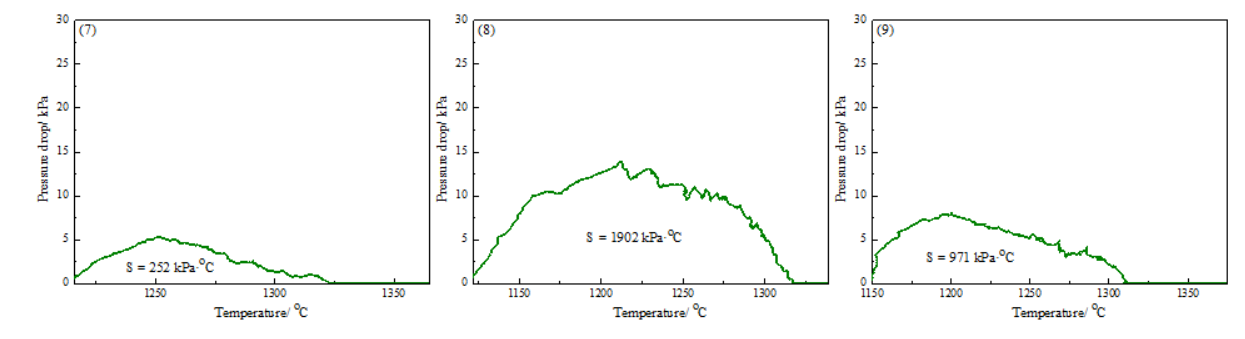
Figure 5. Characteristic number of gas permeability.